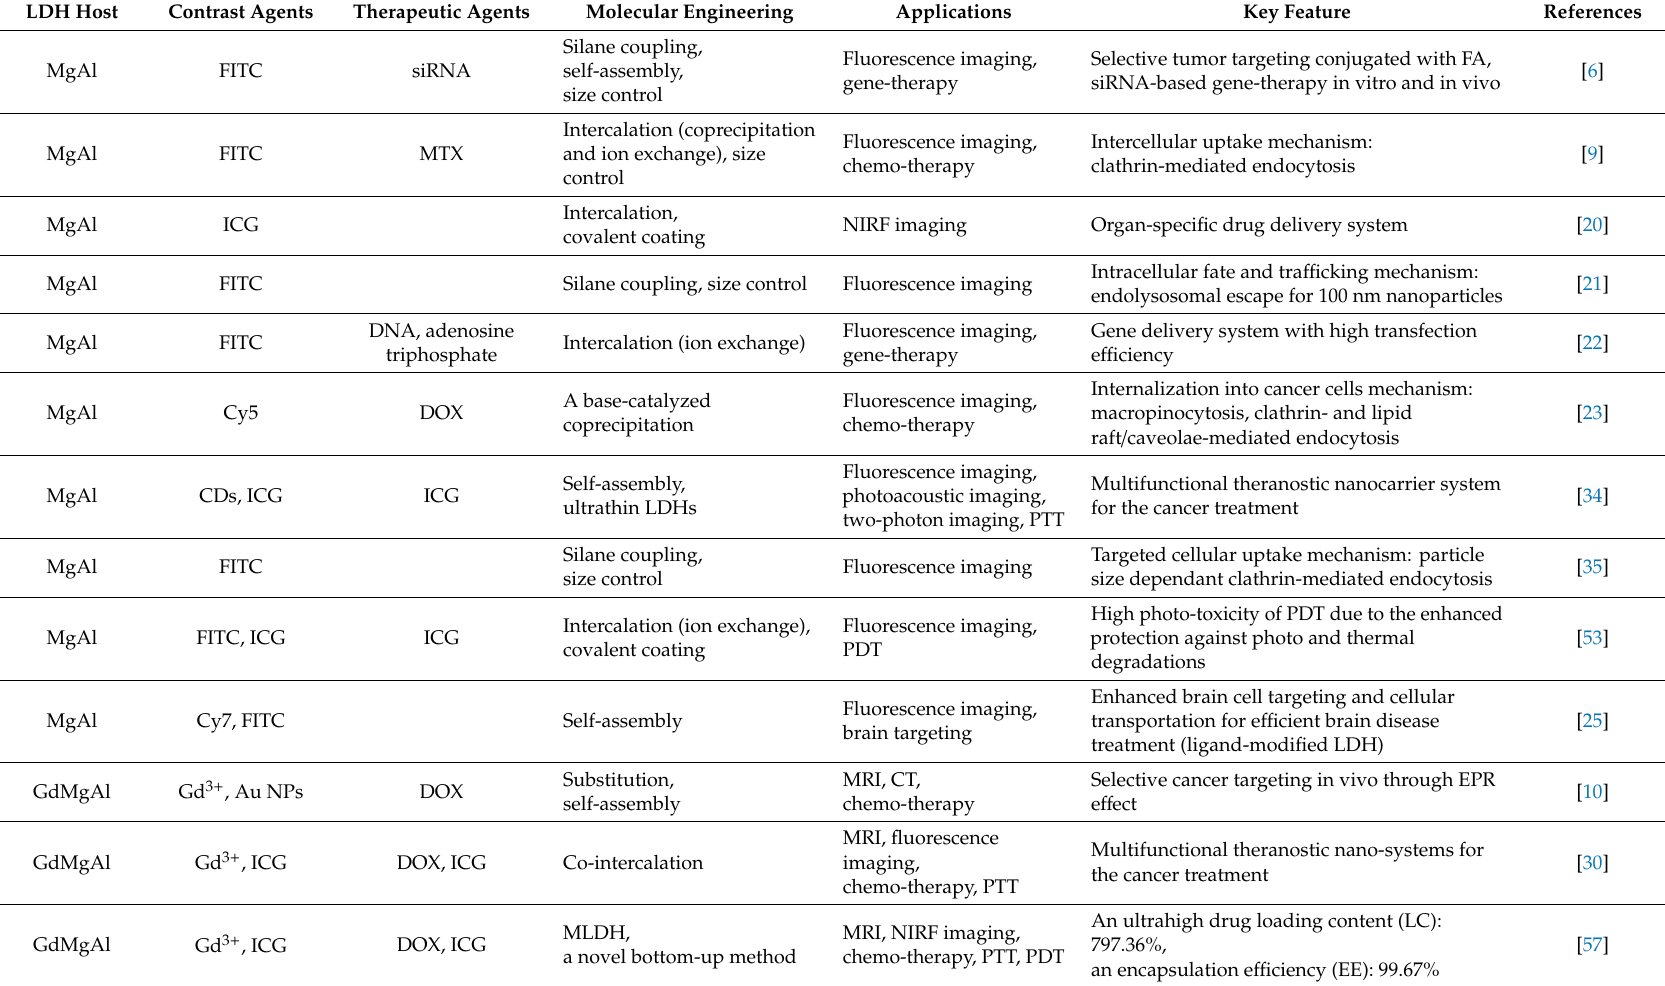
Table 1. A brief summary of LDH nanomaterials for biomedical imaging